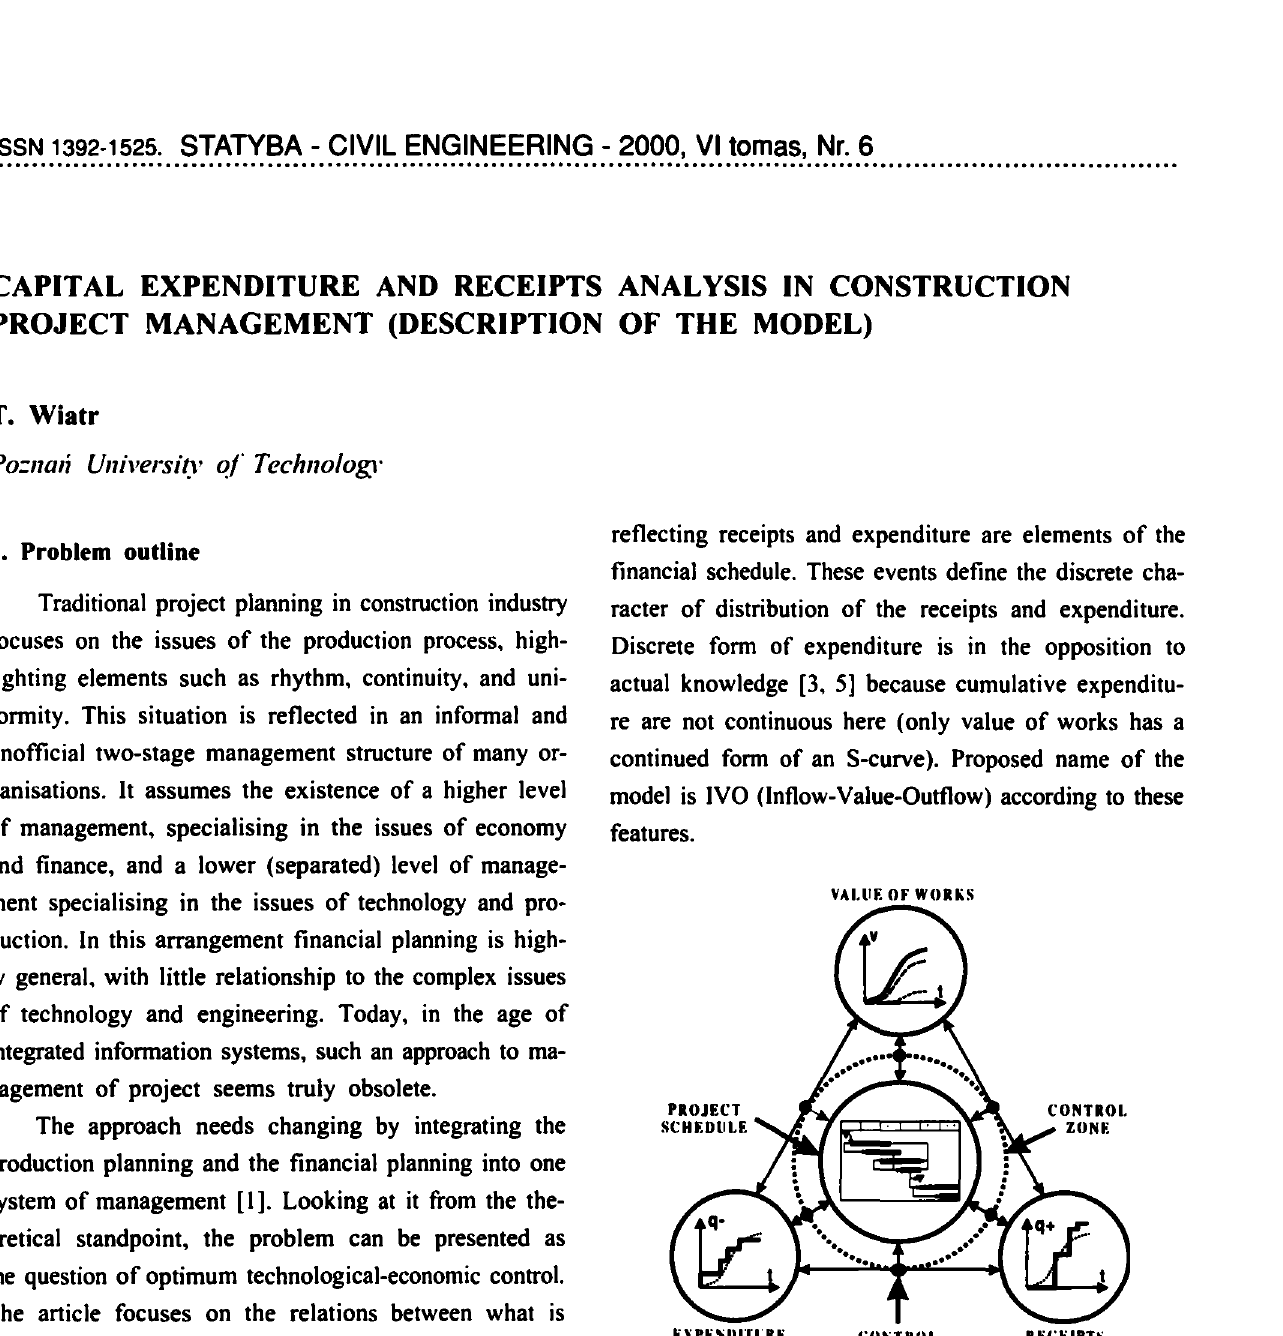
Fig I. Ideograph of project control (simplified